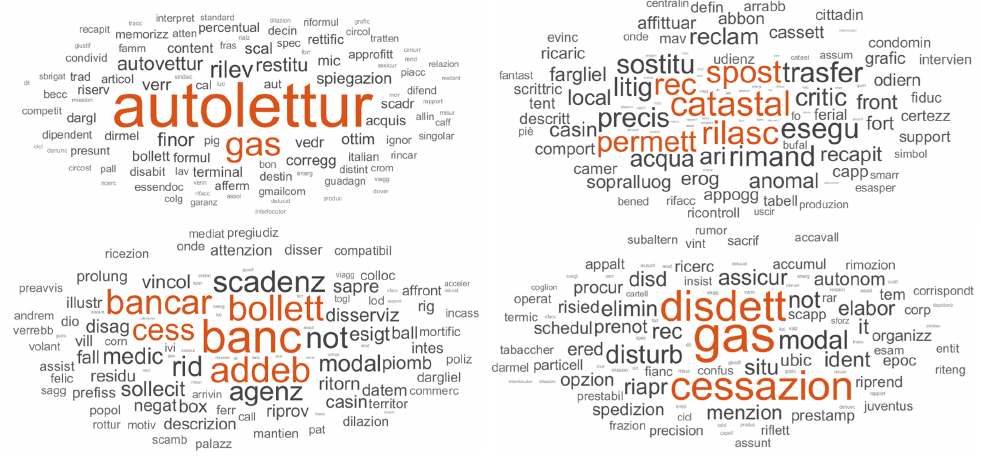
Figure 7. Word clouds of topic k = 3, k = 11, k = 14, and k = 18.